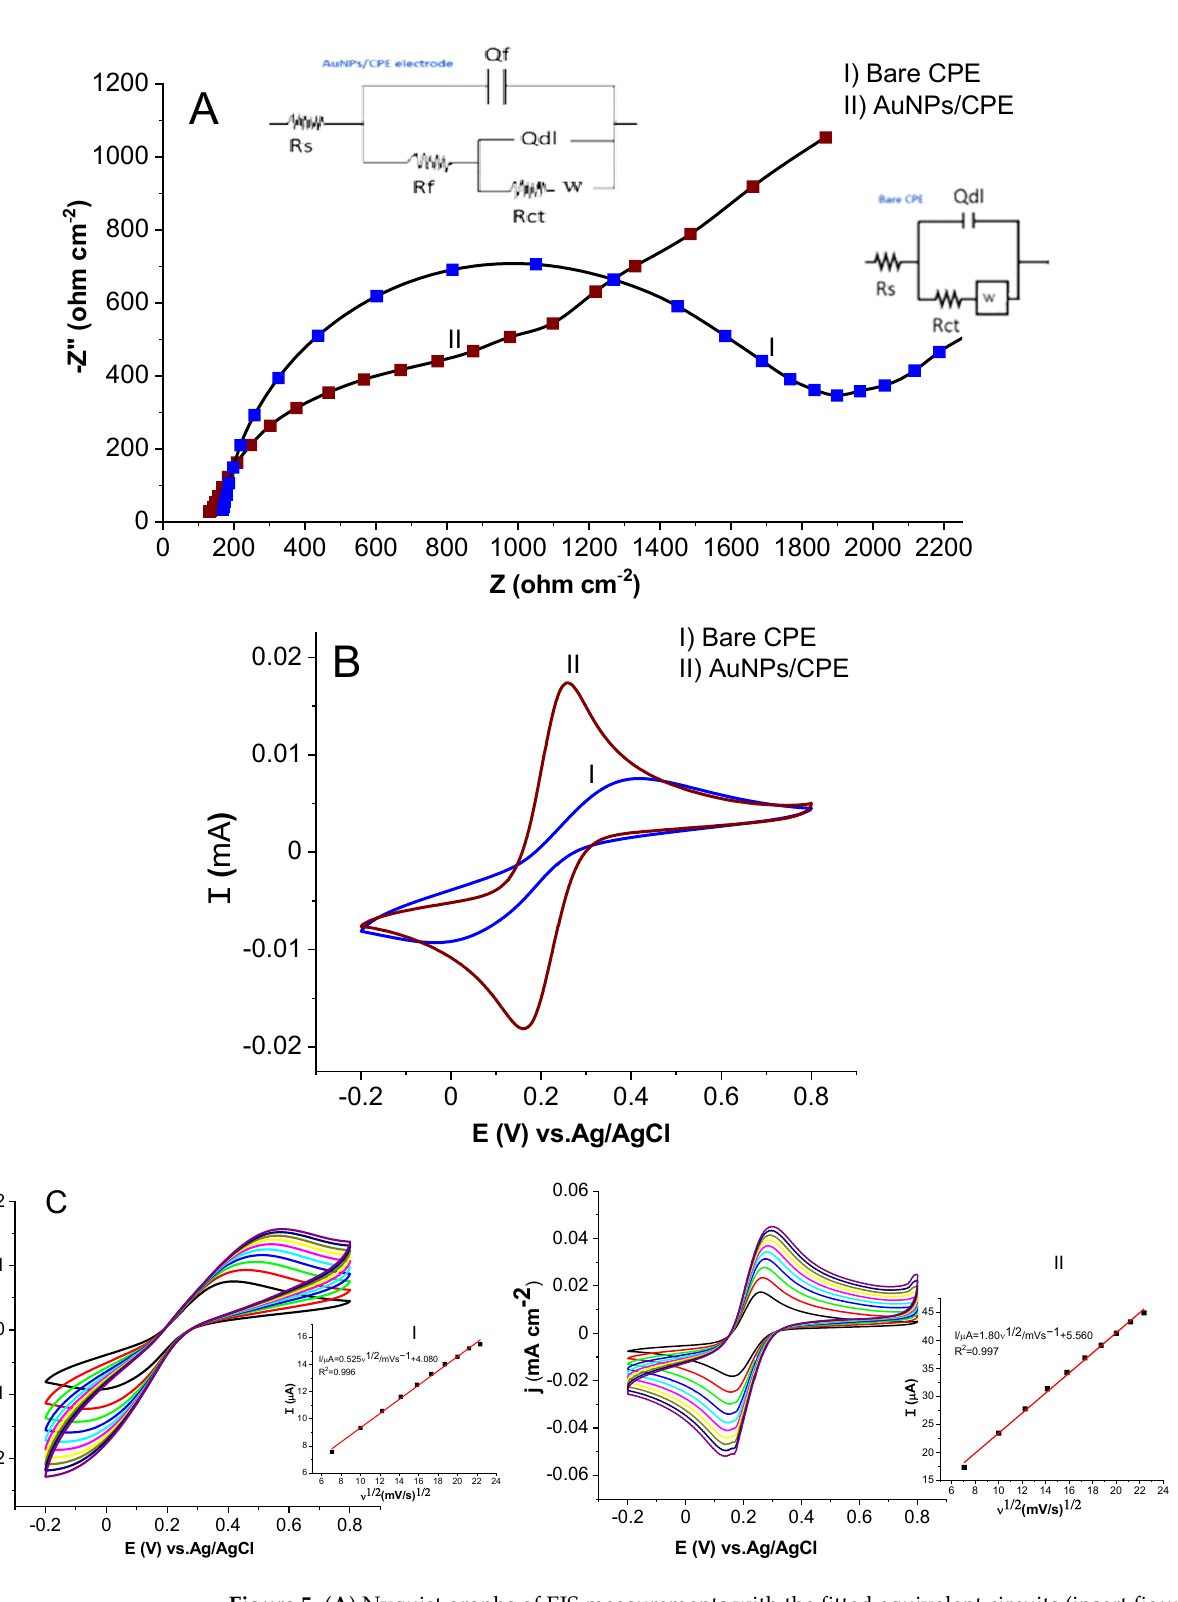
Figure 5. ( A ) Nyquist graphs of EIS measurements with the fitted equivalent circuits (insert figures), ( B ) CV graphs at 50 mV/s, and ( C ) CV in 2 mM [Fe(CN)6] 3−/4− and 0.1 M KCl solution at various scan rates of the (I) bare CPE and (II) AuNPs/CPE. Inset: Peak currents as a function of the square root of the potential.